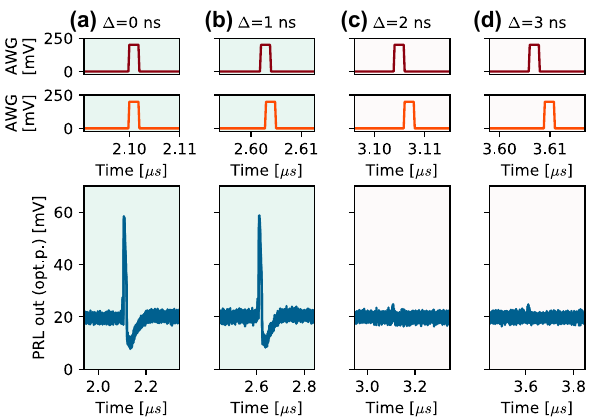
Figure 3: Two-input coincidence detection (logical AND), where the first two rows show the 2 ns square pulses (stimuli) gradually shifting apart in time. For (a) perfect and for (b) partial overlap, the total energy at a given moment surpasses the firing threshold, eliciting a spike. However, as the pulses drift further apart (c, d), the input perturbation energy to the system at any given time is not sufficient for